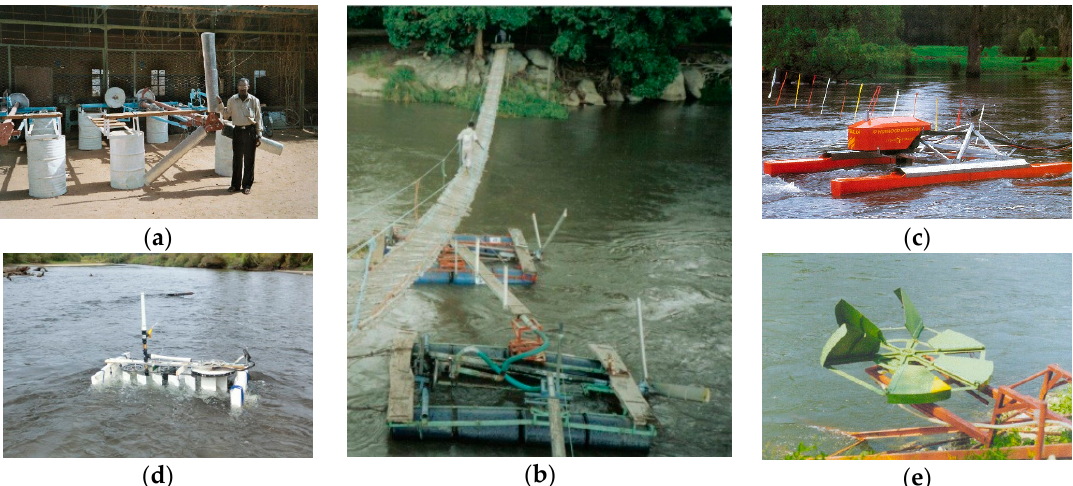
Figure 7. Di ff erent types of water current turbines (WCTs): ( a ) Construction of a Garman turbine (GT). © Thropton Energy Services. Courtesy of Dr. Barbara Sexon; ( b ) Two GTs in operation. © Thropton Energy Services. Courtesy of Dr. Barbara Sexon. Cropped from the original; ( c ) Tyson turbine (TT) in operation. Reproduced with permission from Museum of the Riverina. © Wagga Wagga City Council. Courtesy of Mr. Luke Grealy; ( d ) Hydrokinetic linear turbine operating [129]. Reproduced with permission from John Service. © Tuapeka Turbines (http: // tuapeka-turbines.com / blog / mini-linear-turbine-test-whakatane-river-new-zealand-14-march-2014 / ). Cropped from the original; ( e ) Markovic self-propelled pump [130]. Reproduced with permission from Nataša Markoviˇc. © Vladimir